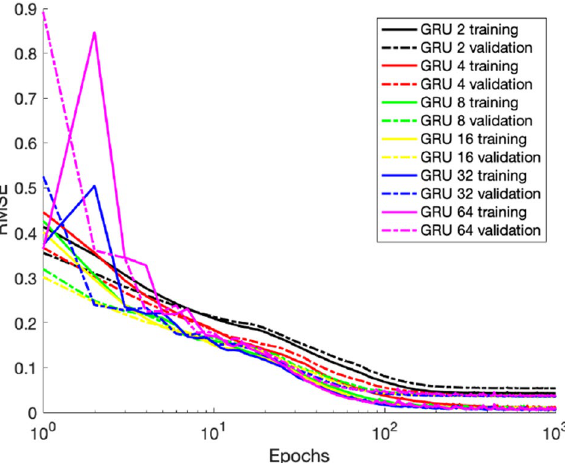
Figure 7. Average training and validation RMSE of ten runs, for 6 different hidden sizes of the GRU-based recurrent layer, for the iteration with the smallest validation loss.